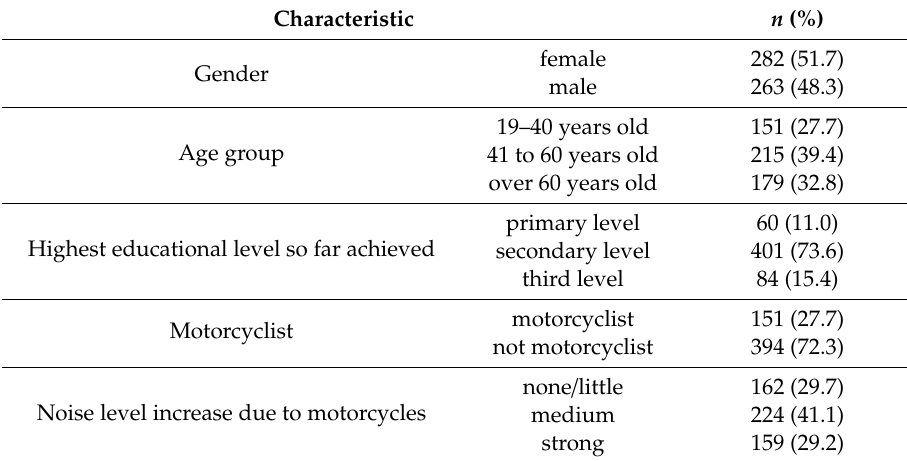
Table 3. Overview of the descriptive statistics for the main study population characteristics of the survey ( n = 545 participants).